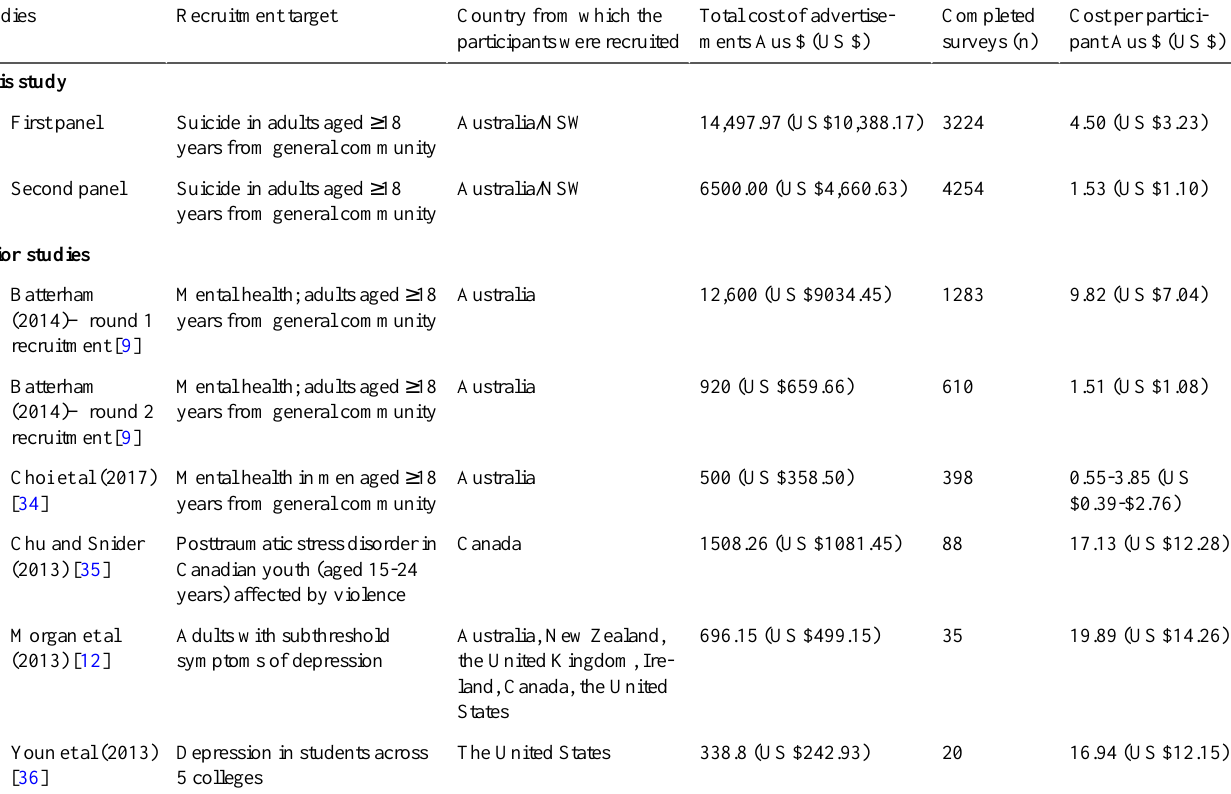
Table 2. Cost-effectiveness comparison of this study with prior mental health studies using social media recruitment methods.